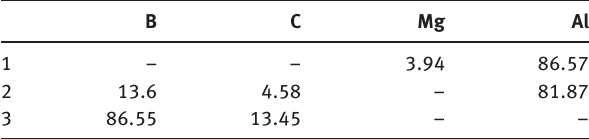
Table 2: EDX analysis result of the